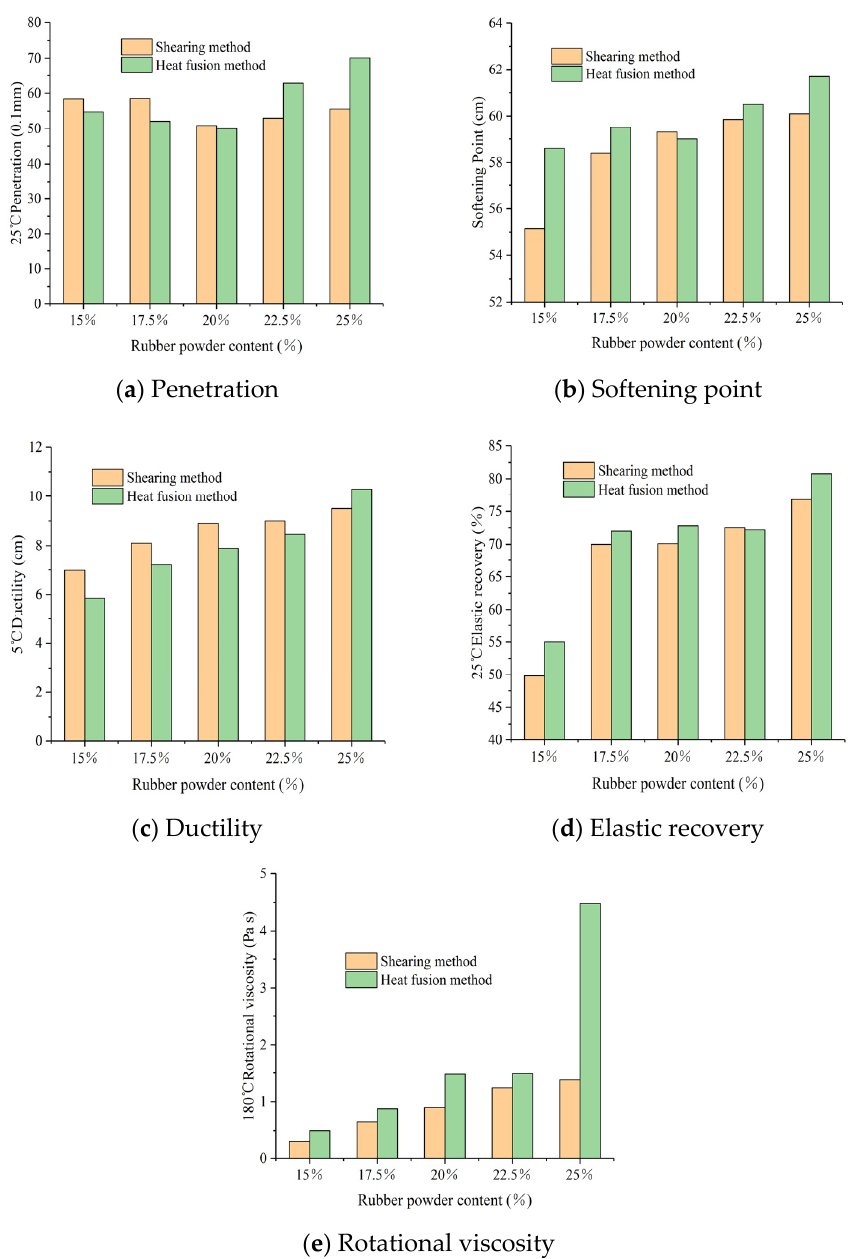
Figure 6. Effect of two stirring methods on the conventional test of AR. Figure 6. E ff ect of two stirring methods on the conventional test of